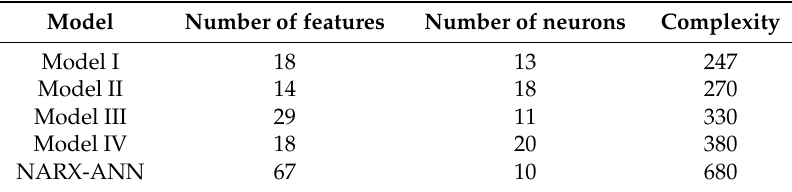
Table 11. Selected multi objective genetic algorithm (MOGA) models and PREVIOUS model. Artificial neural networks: